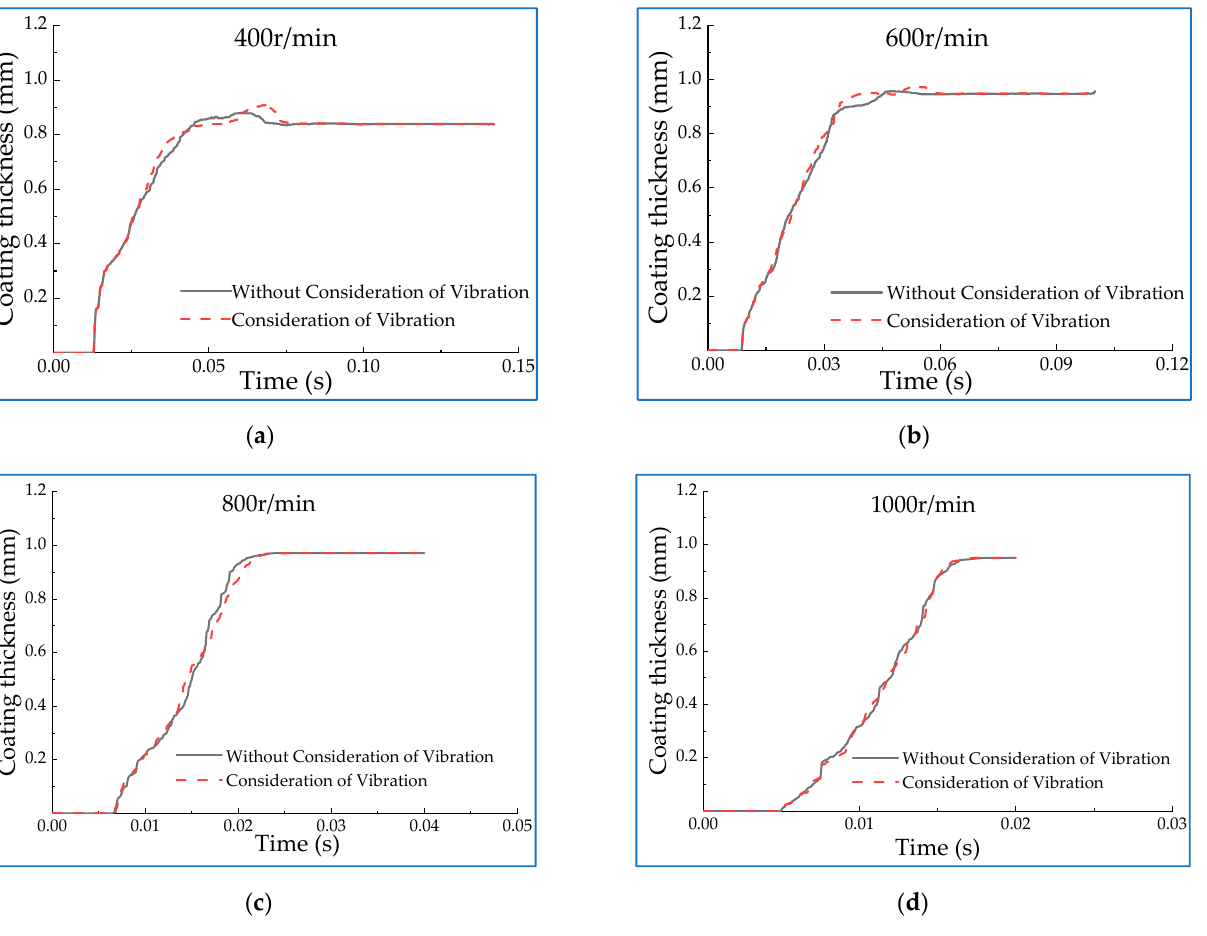
Figure 8. Variation chart of coating thickness at different rotational velocities. At ( a ) 400 rpm; ( b ) 600 rpm; ( c ) 800 rpm; and ( d ) 1000 rpm.